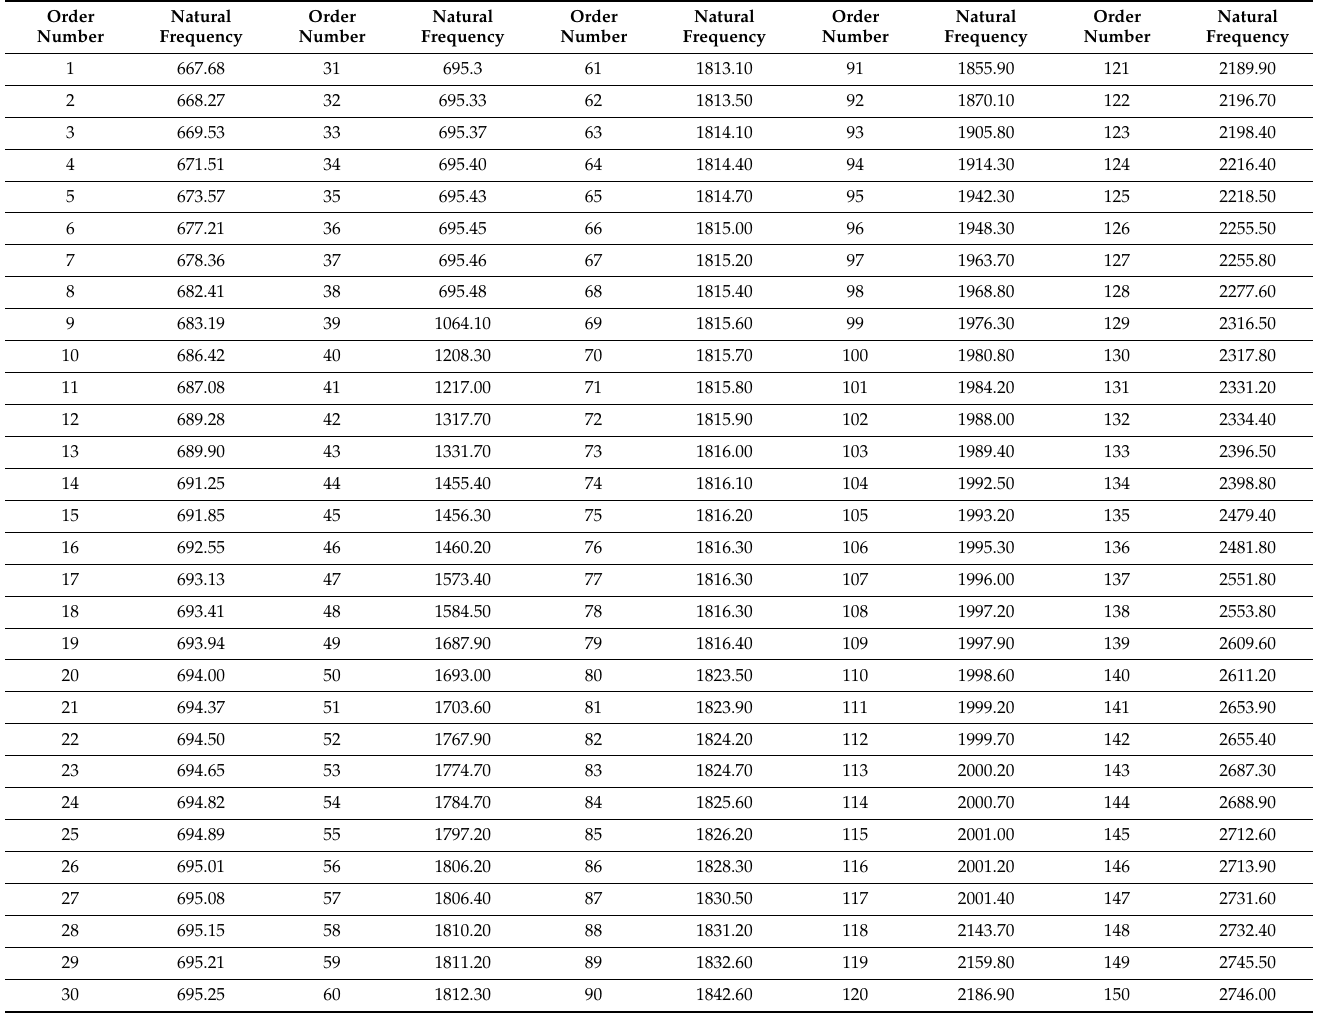
Table 4. Natural frequencies of the first 150 orders of the first-stage blading disk system.